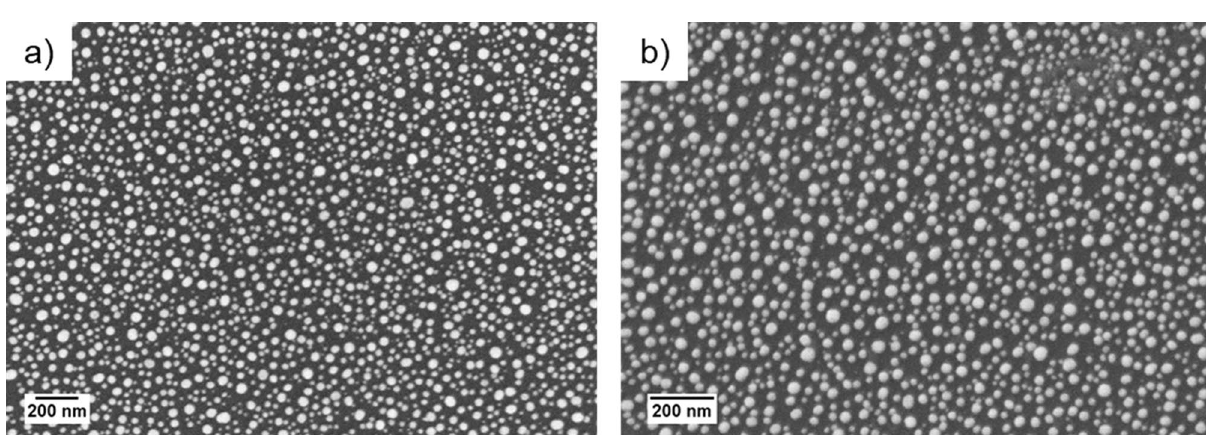
Figure 2. SEM images of (a) the BDD substrate decorated with AuNPs, average diameter 30 nm, and (b) the pBDD substrate decorated with AuNPs, average diameter 30 nm. The SEM images were obtained from a Zeiss XB1540 Crossbeam scanning electron microscope (10 kV operation voltage) and analysed with ImageJ